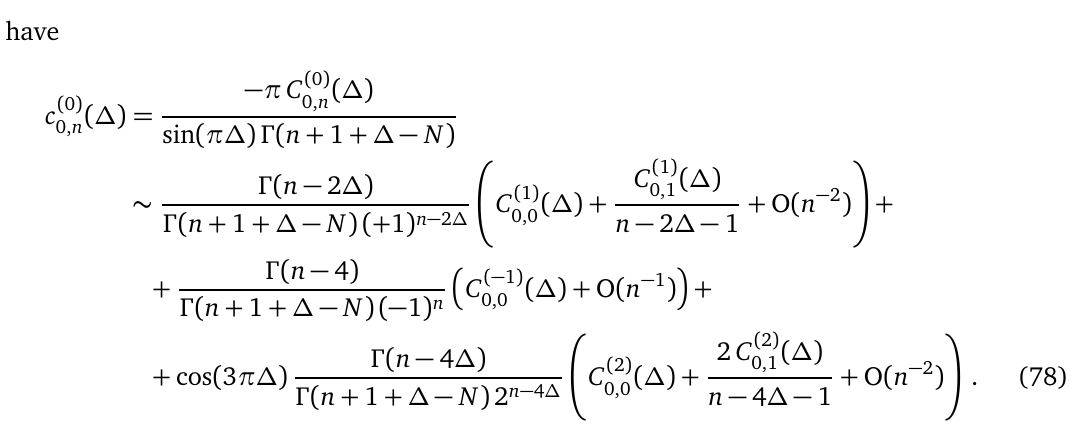
Figure 3: Difference d their asymptotic form C ( − 1 ) ( 1 / 3 ) = sin ( π/ 3 ) y = C 0,0